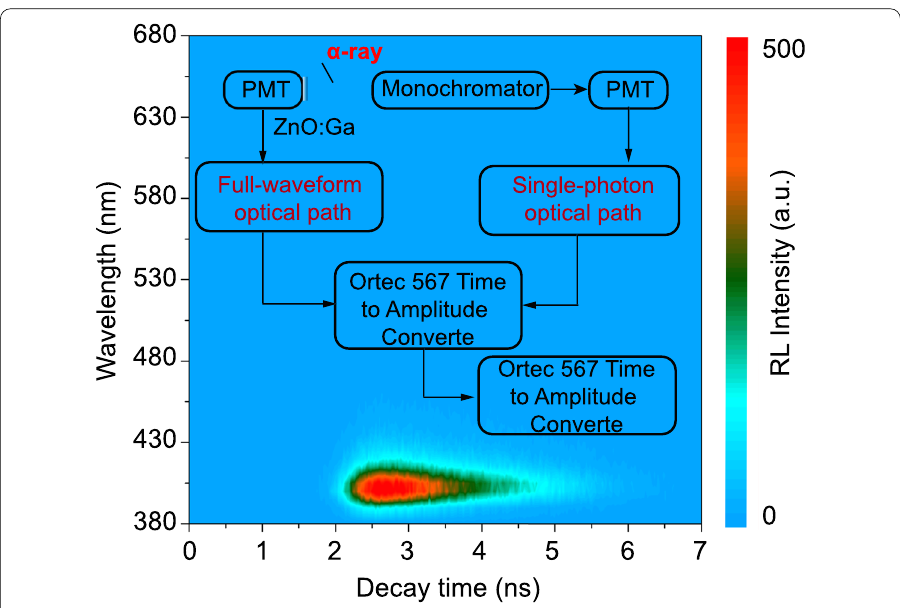
Fig. 4 Time-resolved emission spectrum of ZnO:Ga wafer. The illustration describes the diagram of measurement